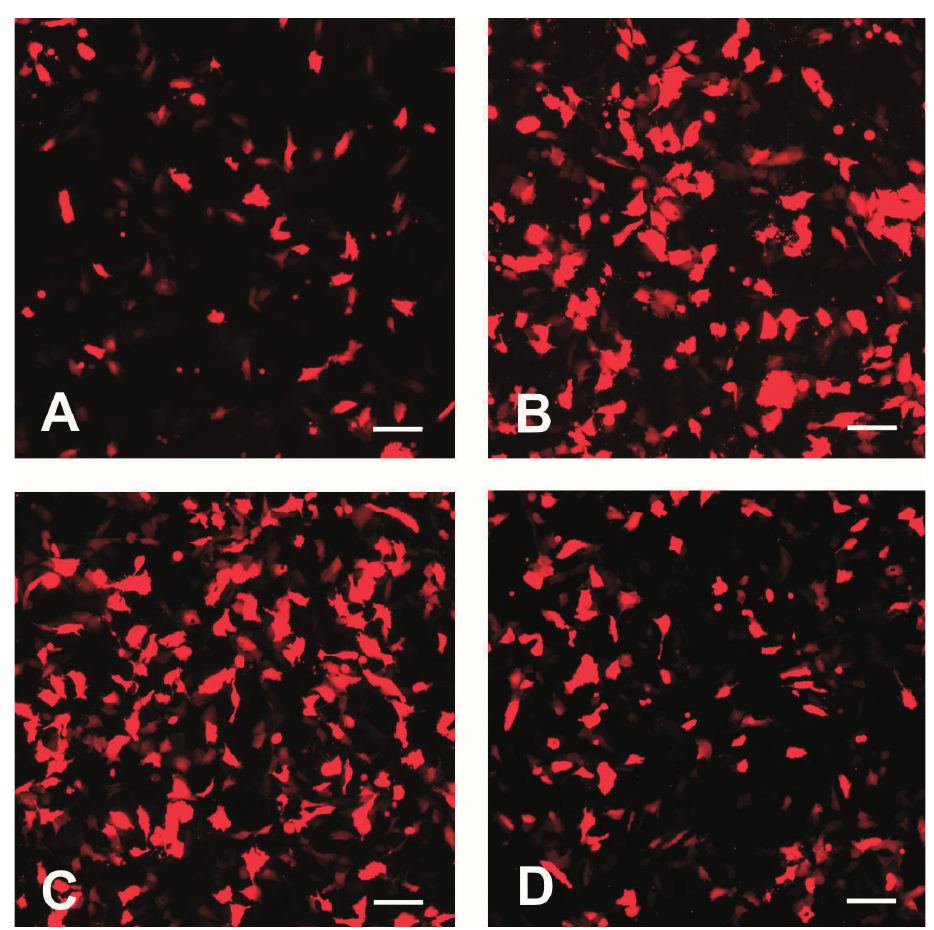
Fig. 3. Successful splicing of the intron. HeLa cells were transiently transfected with pcDNA3.1 (+) plasmid containing intron cloned DsRed2 gene. Expression of red fluorescence at (a) 24 h;